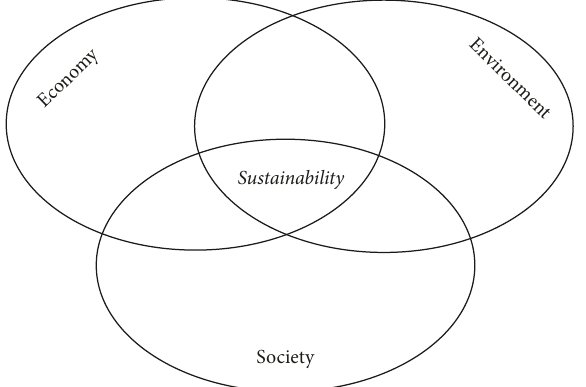
Figure 1: Representation of the three pillars of